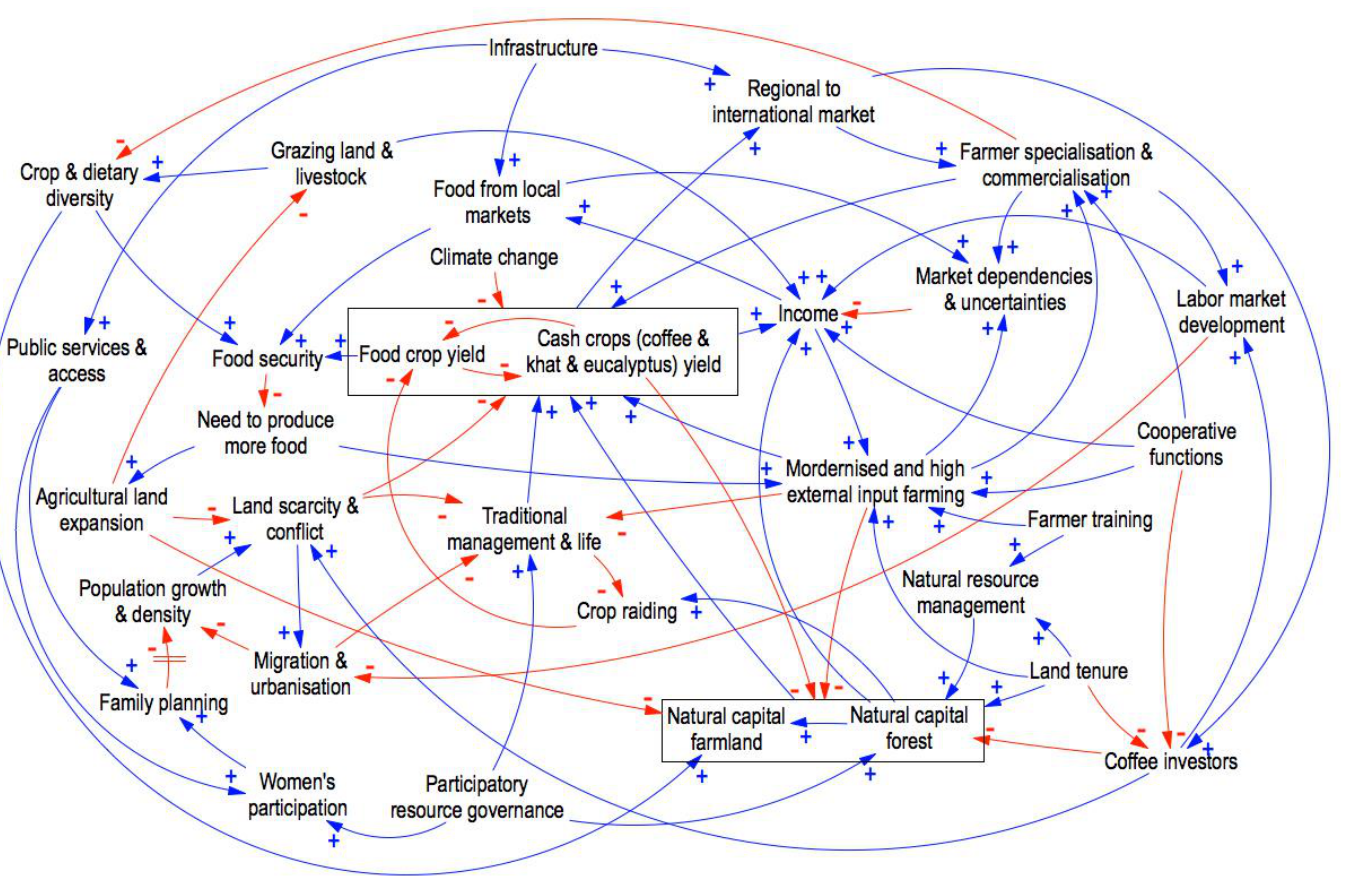
Figure A1.1. Causal loop diagram indicating how drivers of change in the system affect one another. Red arrows with a negative sign (→ - ) indicate a reducing effect and blue arrows with a positive sign (→ + ) indicate an enhancing effect of one variable onto another. The crossed arrow between family planning and population growth (⇞ −) indicates a temporal delay between the variables.